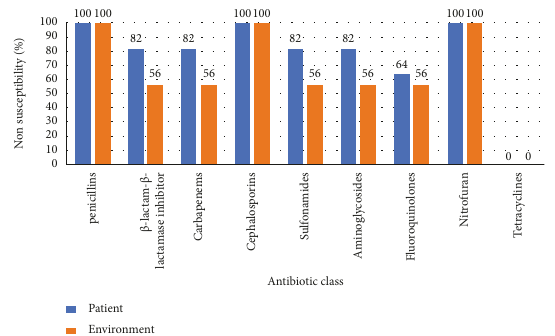
Figure 2: Percentage of nonsusceptibility of A. baumannii to different antibiotic